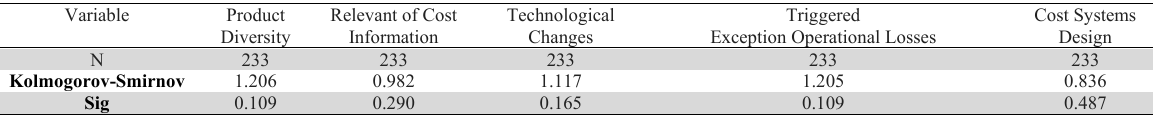
Normal Distribution Test